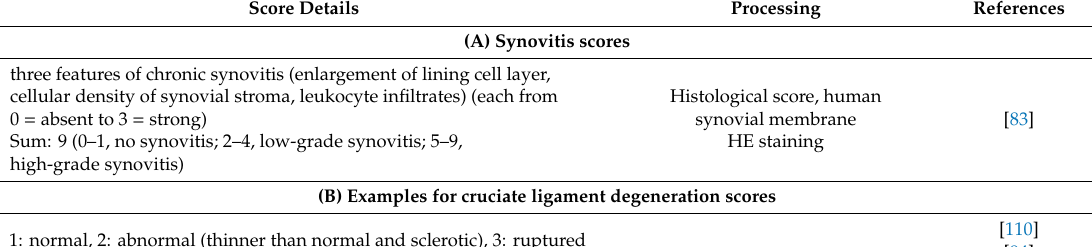
Table1. Macroscopicalandhistologicalscores / keyfeaturesappliedtomeasuresynovitis( A ),degeneration of the ACL ( B ).